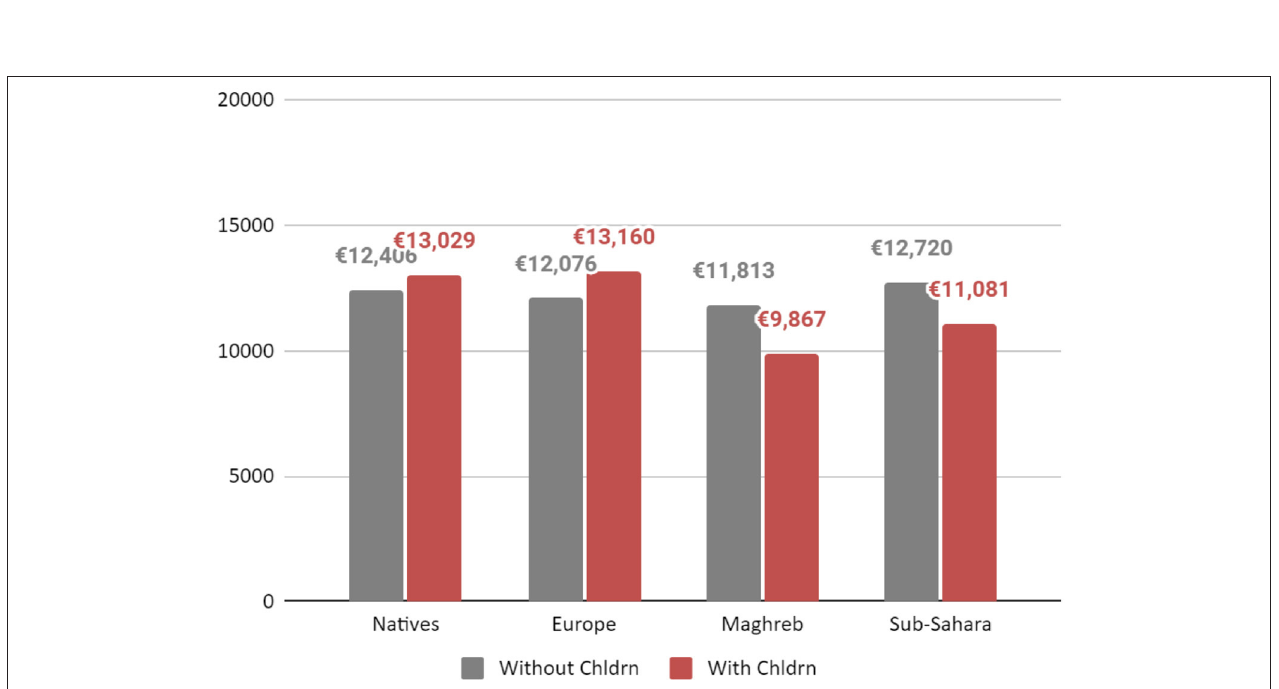
CHART 4 | The yearly income of a woman, in the French labor market according to origin groups and children under 6 years old. Source: Enquête sur les revenus fiscaux et sociaux (ERFS), INSEE 2009–2012.